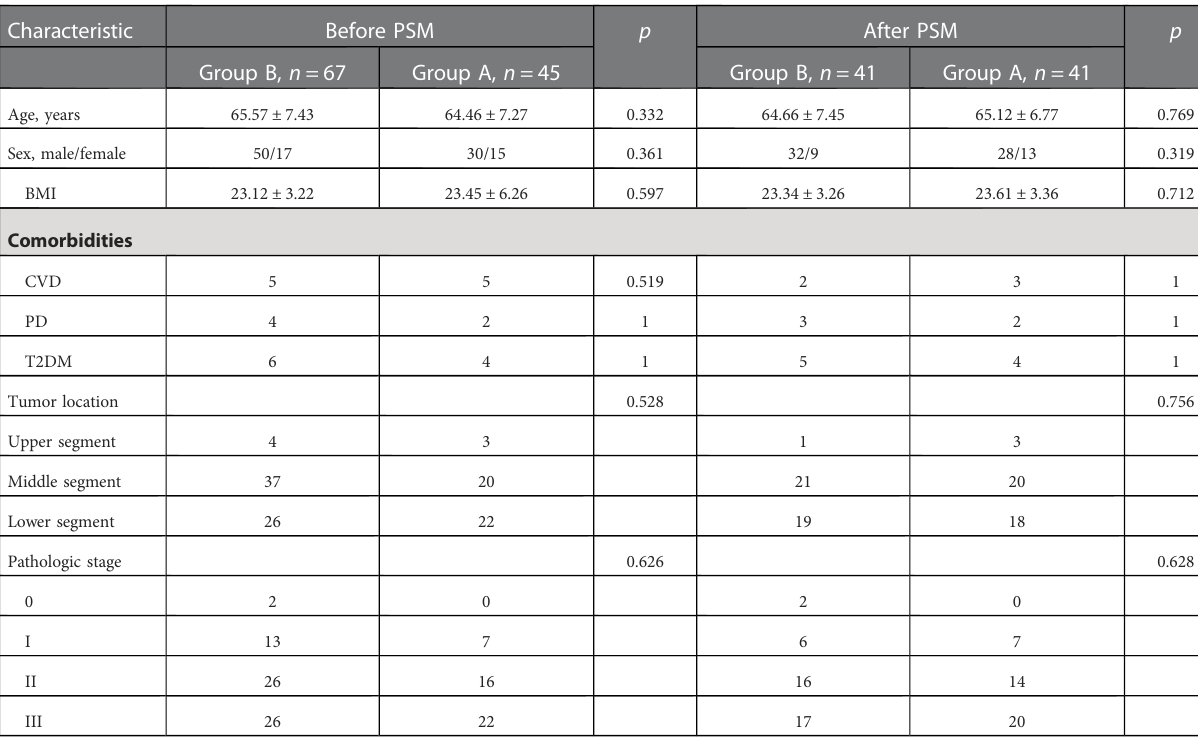
TABLE 1 Characteristics of patients in two